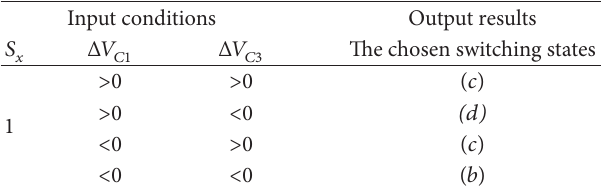
Table 5: Control table for capacitor voltage: 𝑆 𝑥 = 1 .